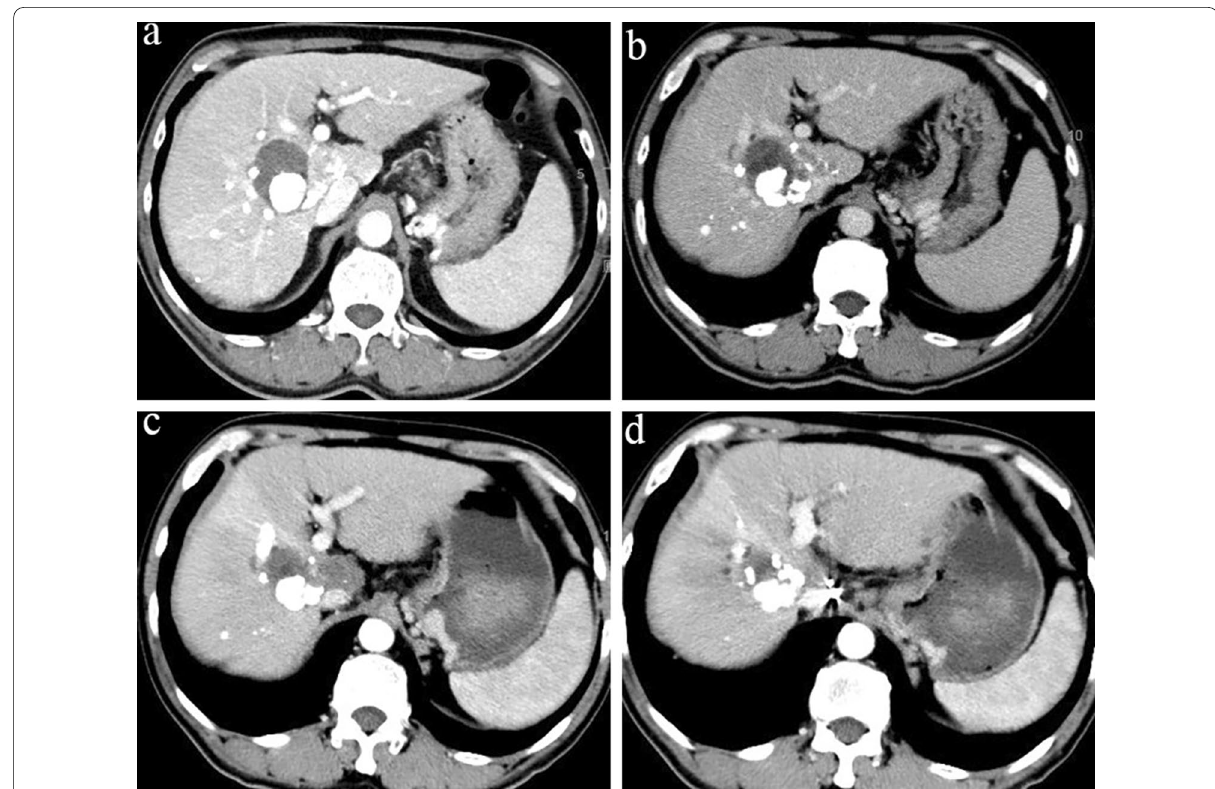
Fig. 2 Contrast-enhanced computed tomography (CT) of a 69-year-old man with primary liver cancer (5.6 cm) adjacent to inferior vena cava and portal vein. Contrast-enhanced CT showed abnormal enhancement of liver S1 segment at 1 month after TACE ( a ). CT-guided MWA was performed but contrast-enhanced CT still showed residual tumor lesion ( b ) after 1 month. Three months after the CT-guided. 125 I seed implantation, the residual tumor lesions showed no enhancement ( c , d )